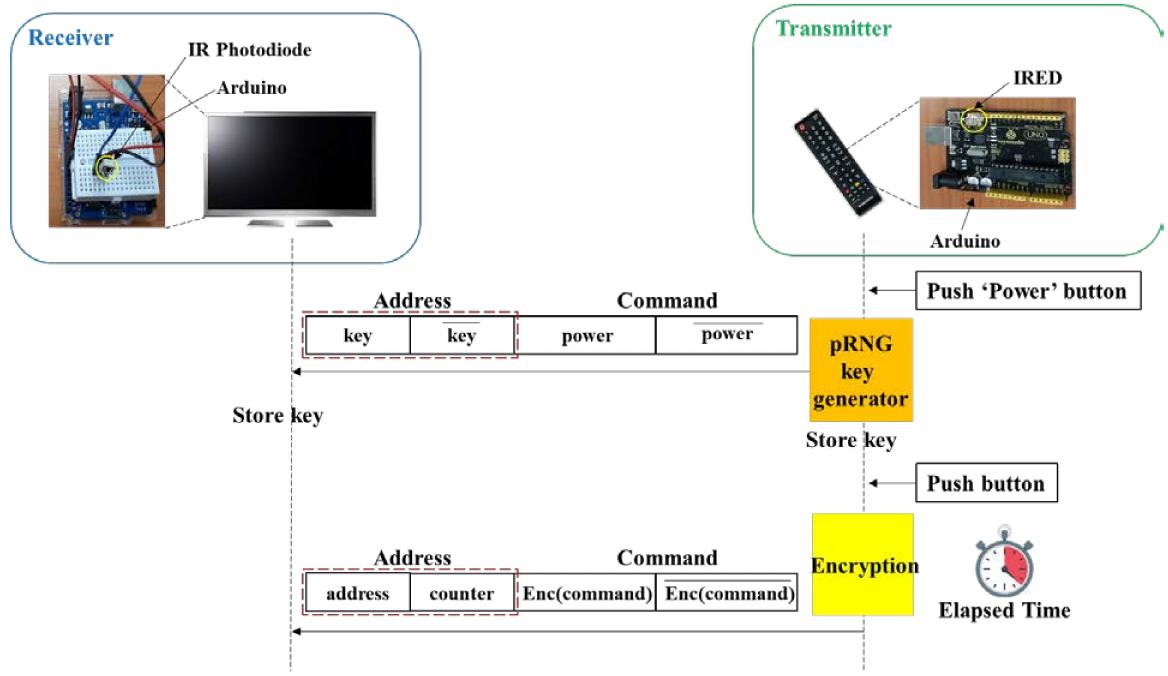
Figure 18. Experimental setup for performance